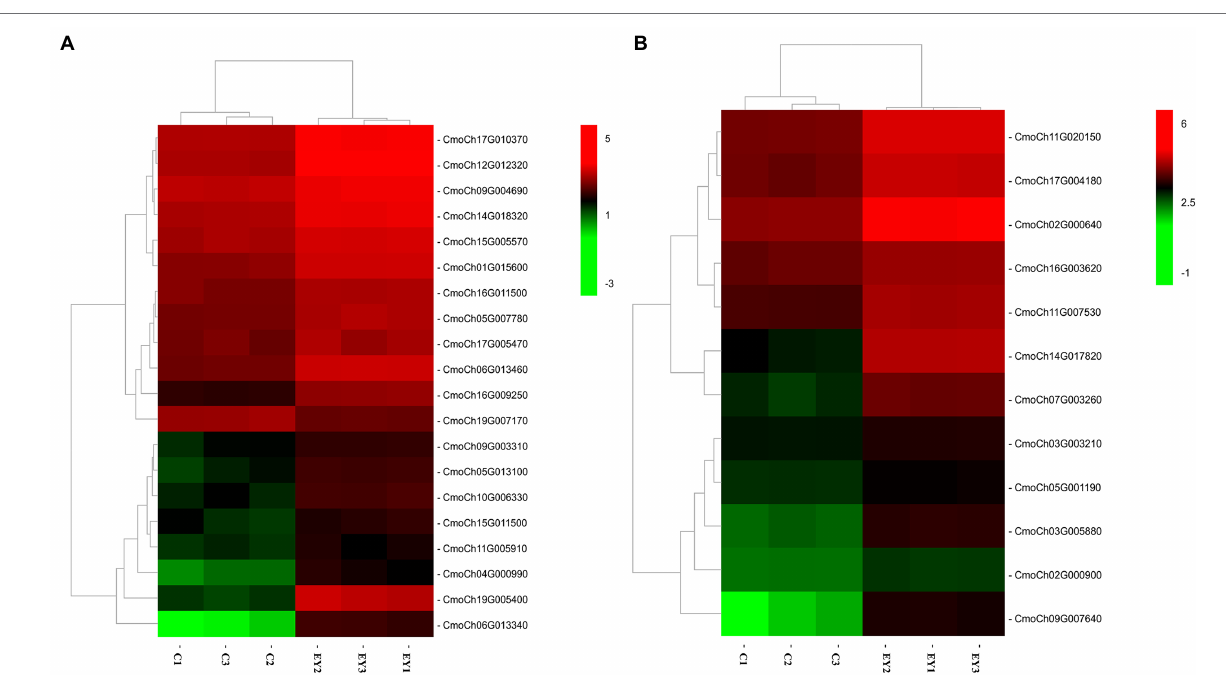
FIGURE 5 | Heatmap diagram of expression levels of DEGs in significant enrichment KEGG pathways. (A) DEGs enriched in plant hormone signal transduction pathway. (B) DEGs enriched in cysteine and methionine metabolism pathway. The red and green colors indicate high and low expression levels (log 2 FPKM),